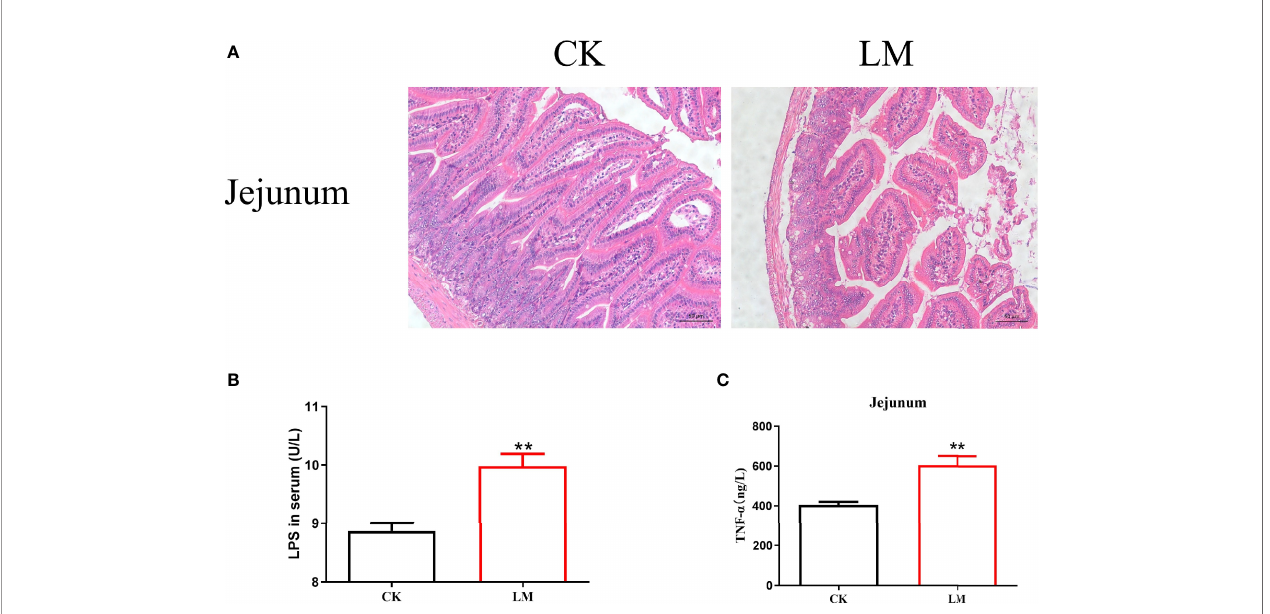
FIGURE 1 | The intestinal pathological changes in mice after L. monocytogenes infection. CK, control, orally challenge with PBS; LM, L. monocytogenes -infected group. (A) Histopathological changes in jejunum tissues were examined by hematoxylin eosin (HE) staining. (B) The concentration of LPS was measured in serum. (C) The concentration of TNF- a was measured in jejunum. Data is presented as mean ± SD. ** P < 0.01. Data combined from at least three independent experiments unless otherwise